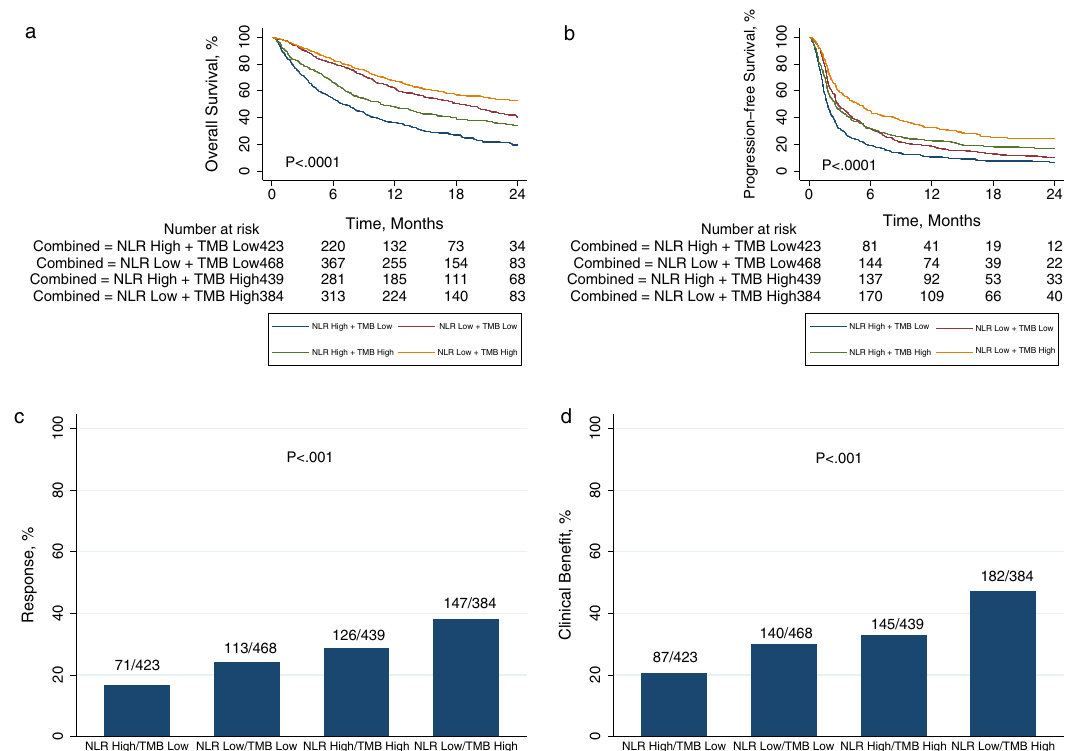
Fig. 3 Pan-cancer outcomes according to a combined neutrophil-to-lymphocyte ratio (NLR) and tumor mutational burden (TMB) categorization. a Overall survival, b progression-free survival, c response, and d clinical bene fi t at a pan-cancer level. Patients were classi fi ed into four categories based on NLR low/high and TMB low/high, using median within cancer type as cutoff for both variables. P -values are according to log-rank test for a and b , and Pearson ’ s χ 2 -test for c and d